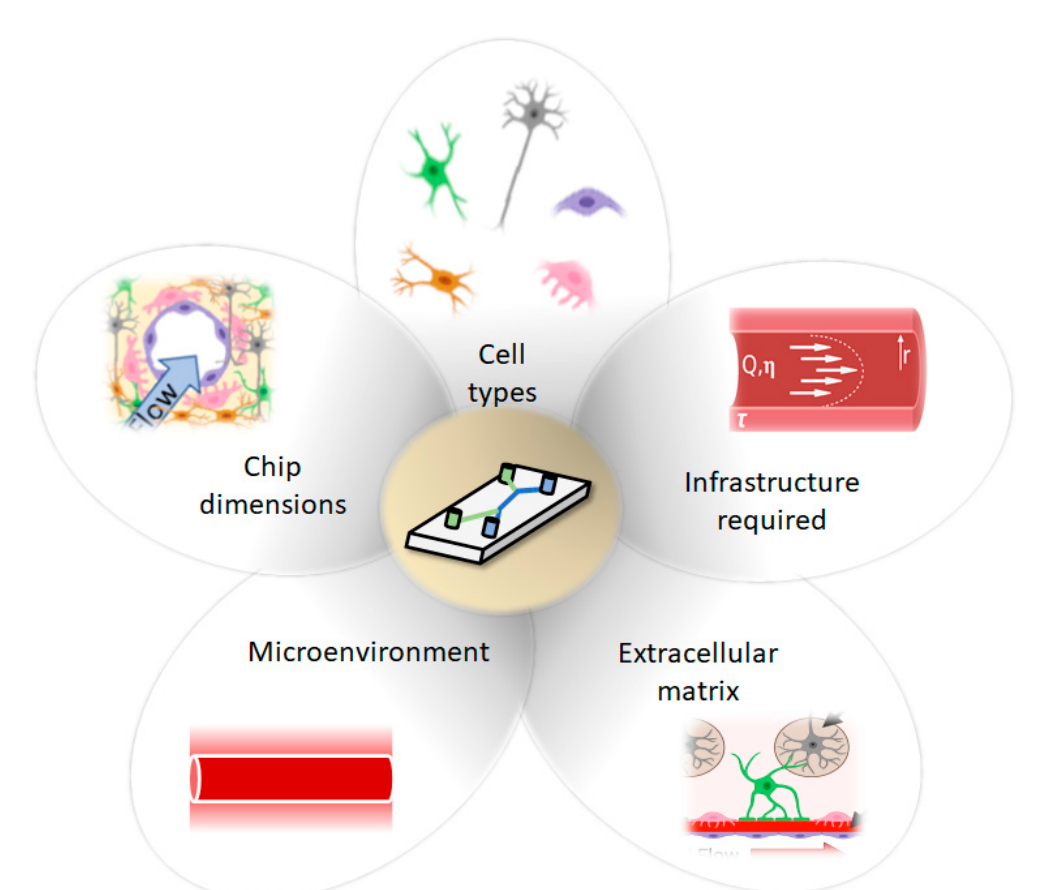
Figure 1. Considerations for development of Brain-on-a-Chip (BoC) models include cell types, chip dimension (2D, 2.5D, 3D), infrastructure required, ECM and microenvironment.